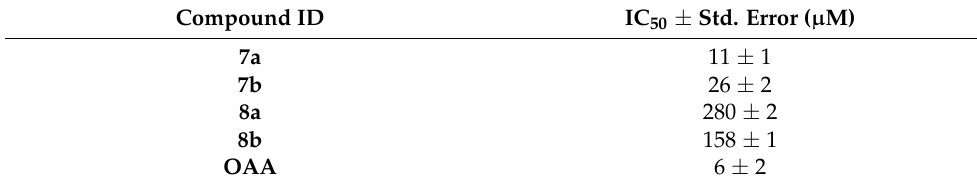
Figure 5. N - β -naphthyl-oxalamic acid methyl ester ( 7a ) and -acid ( 7b ) and N - α -naphthyl oxalamic acid analogs ( 8a , 8b ). Table 2. N - β -naphthyl oxalamic acid derivatives ( 7a , 7b ). N - α -naphthyl oxalamic acid derivatives ( 8a , 8b ). Data fit with GRAPHPAD PRISM 5. Standard error of the fit given in µ M. IC 50 diagrams including the fit and standard deviations of the individual experiments ( n = 3) are depicted in the Supplementary